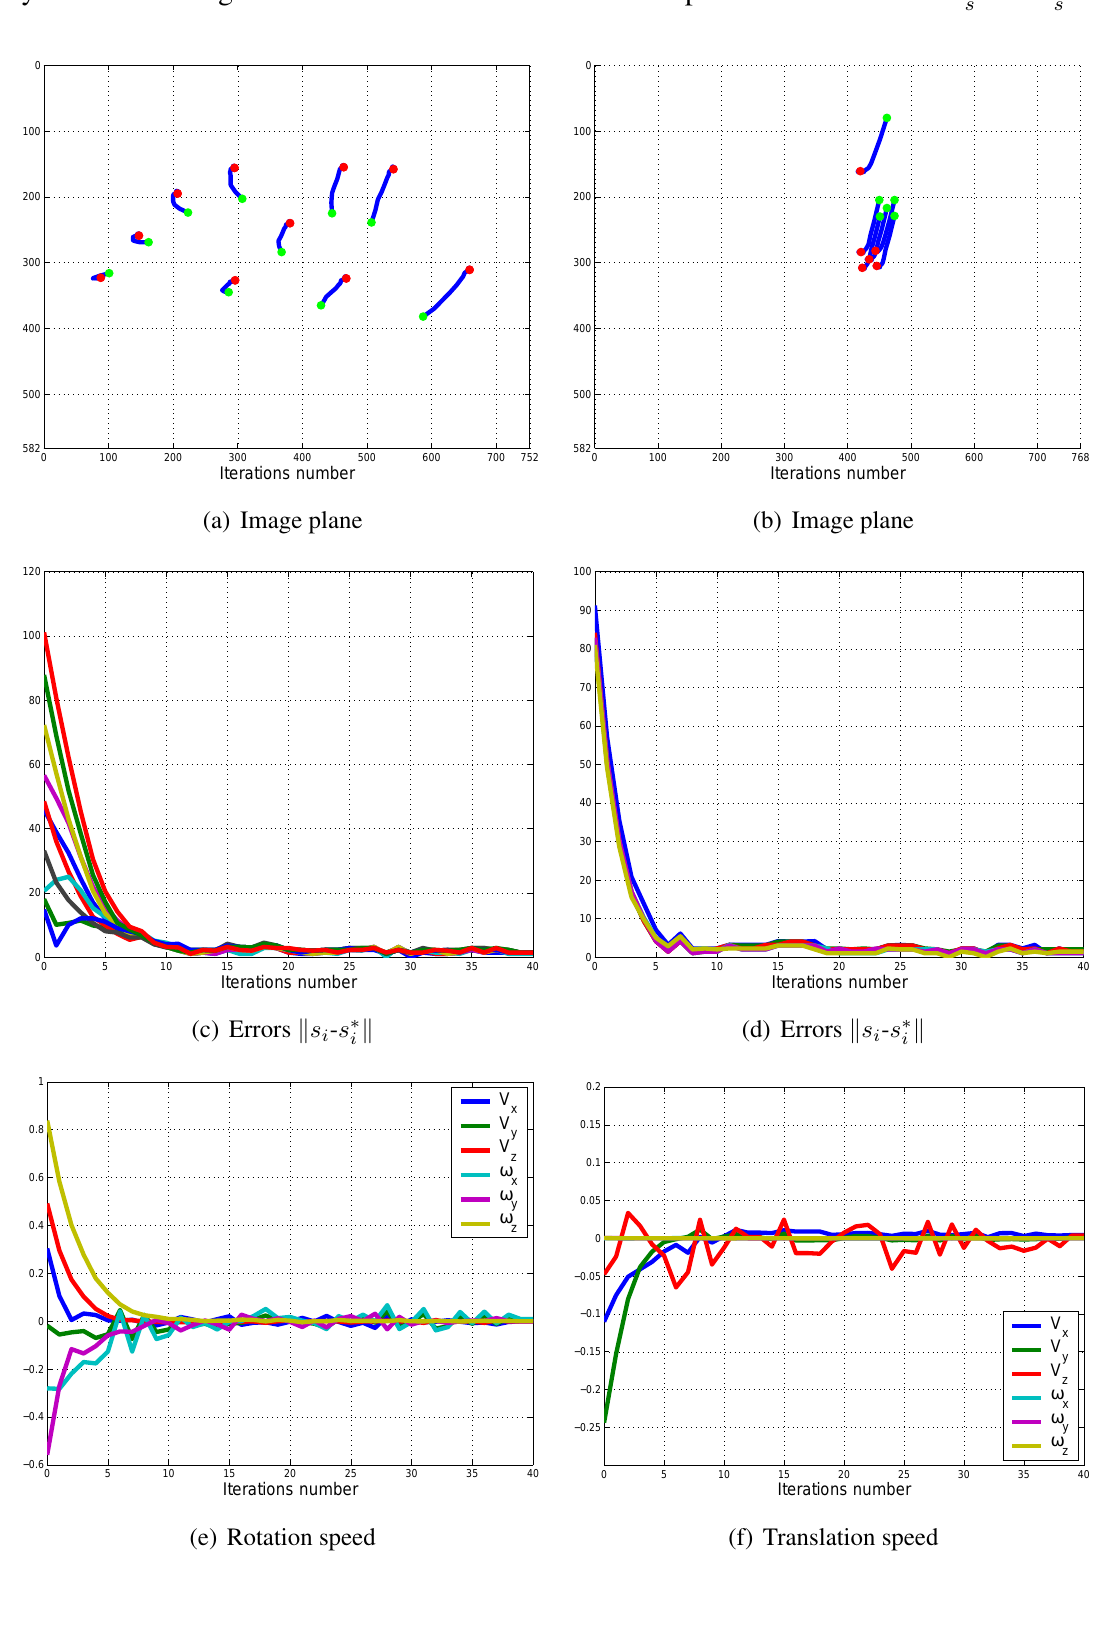
Figure 12. Results with variable values of k the camera in eye-in-hand configuration and figures (b,d,f) are the same for the camera in eye-to-hand configuration. The translation and rotation speeds are measured in m